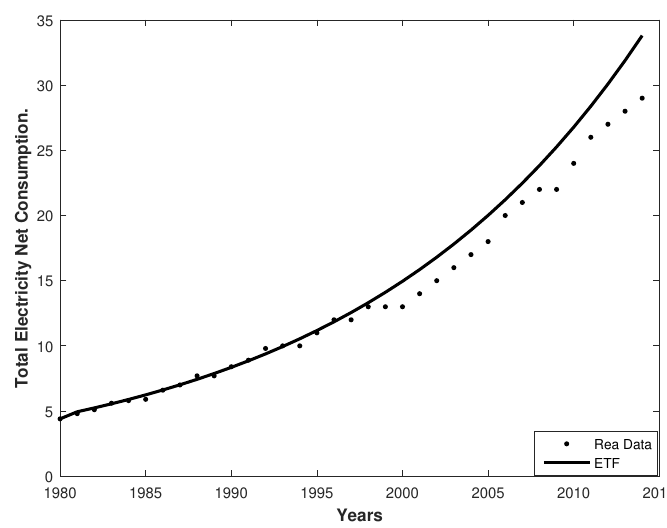
Figure 4. The real data versus those fitted by the stochastic Lognormal Diffusion Process (LDP).